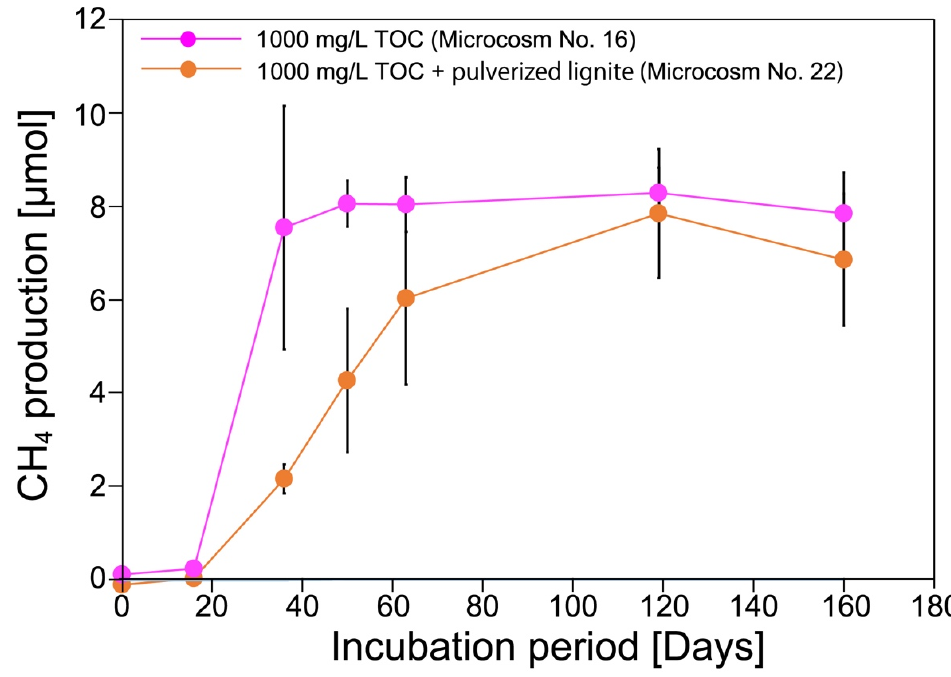
Figure 4. Methane production in microcosms using SAL25-2. Only results of microcosms amended with chemically solubilized lignite solution with 1000 mg/L TOC were shown in this figure (Micro- cosms No. 16 and 22) because little to no methane was produced during the incubation period of the current study when 100 or 10 mg/L TOC of chemically solubilized lignite solution was used.